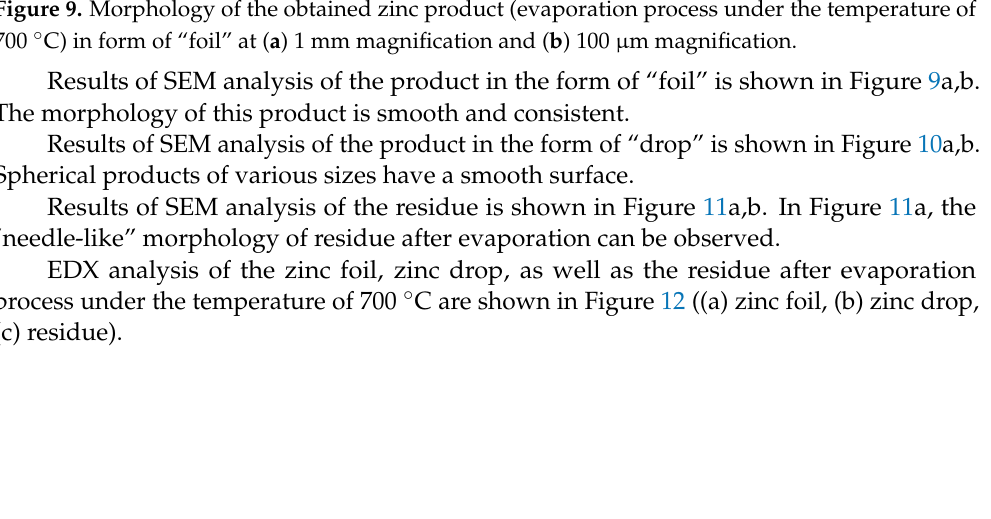
( b ) Figure 10. Morphology of the obtained zinc product (evaporation process under the temperature of 700 °C) in the form of “drop” at (a) 500 µm magnification and (b) 200 µm magnification. Results of SEM analysis of the product in the form of “drop” is shown in Figure 10a,b. Spherical products of various sizes have a smooth surface.